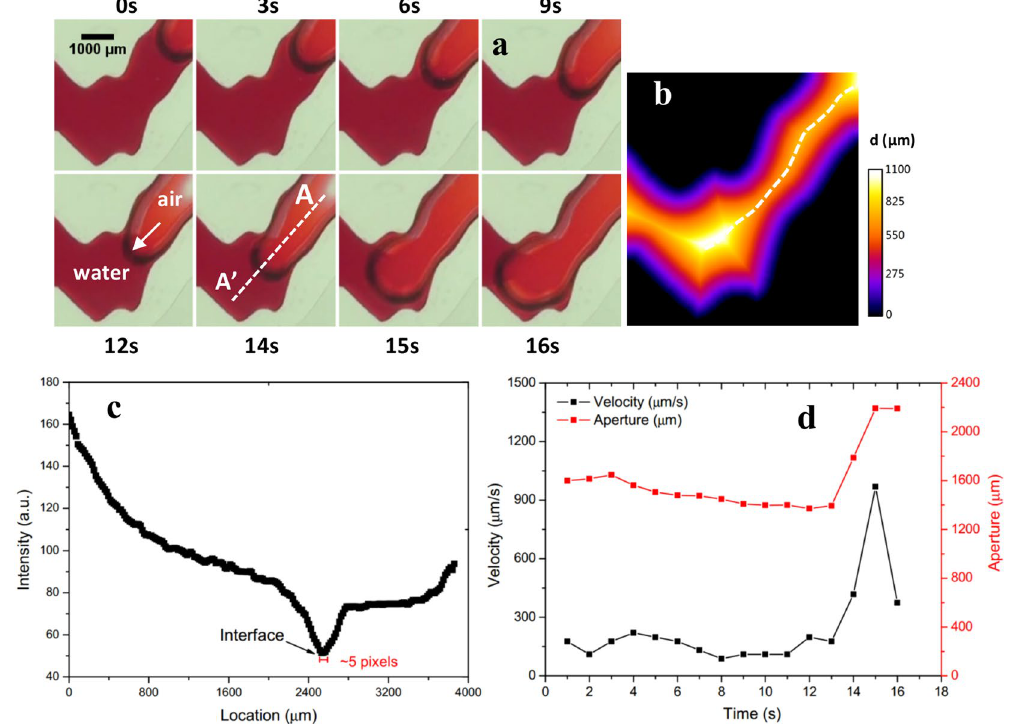
Figure 1. ( a ) Sample images demonstrating temporal Haines jump during air drainage. ( b ) Distance map of pixels within the fracture domain to the two impervious walls. The white dotted line indicates the maximum distance to the two boundaries, which is regarded as the flow-pathway centre. ( c ) Intensity profile along transect A-A’ showing reduced value at air-water interface, which is used for unambiguous interface discernment. ( d ) Temporal changes in interfacial velocity and width of aperture through which menisci flows. The white arrow in ( a ) indicates the air-water interface.